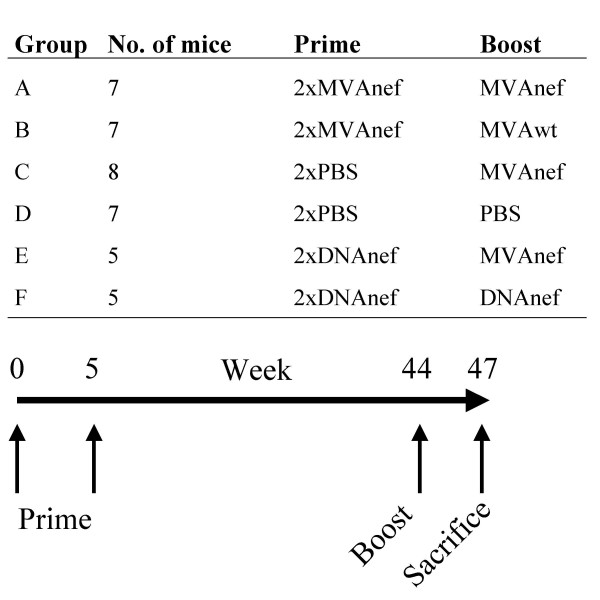
Experimental setup.